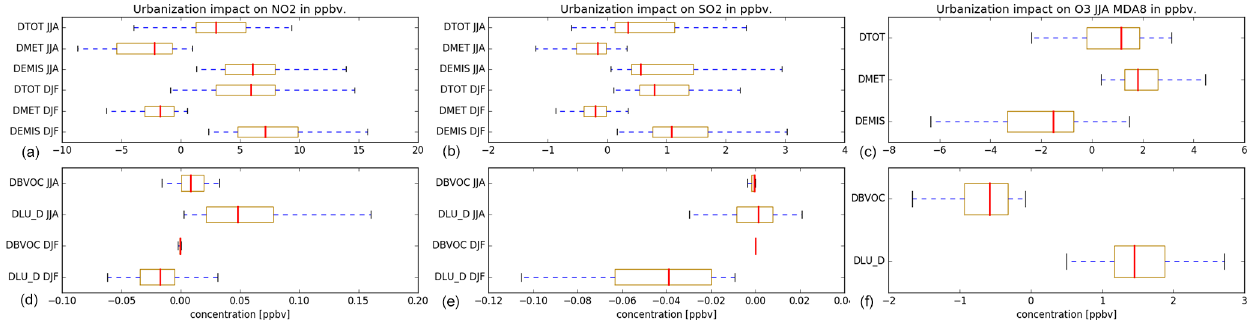
Figure 3. The 2015–2016 DJF and JJA averaged impact of each contributor to the rural–urban transformation including the total impact averaged over all chosen cities for NO 2 , SO 2 , and O 3 in parts per billion by volume (ppbv). In the case of ozone, only the summer averaged MDA8 (maximum daily 8h average) is shown. The box plots show the 25% to 75% quantiles including the minimum and maximum value across all cities. The red line shows the median. Values are taken from the model grid cell that covers the city center. Panels (a) – (c) show the two main contributors including the total impact (DEMIS, DMET, and DTOT), while panels (d) – (f) show the minor contributors (DLU_D and